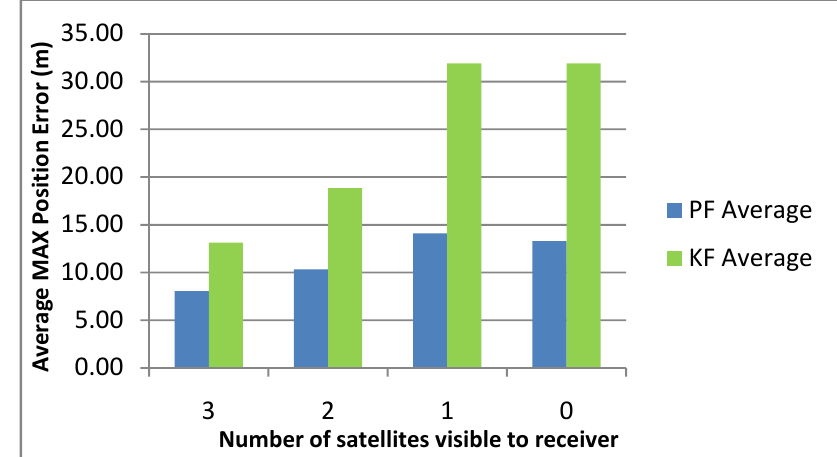
Figure 4. Average maximum position error over the 10 outages in Kingston